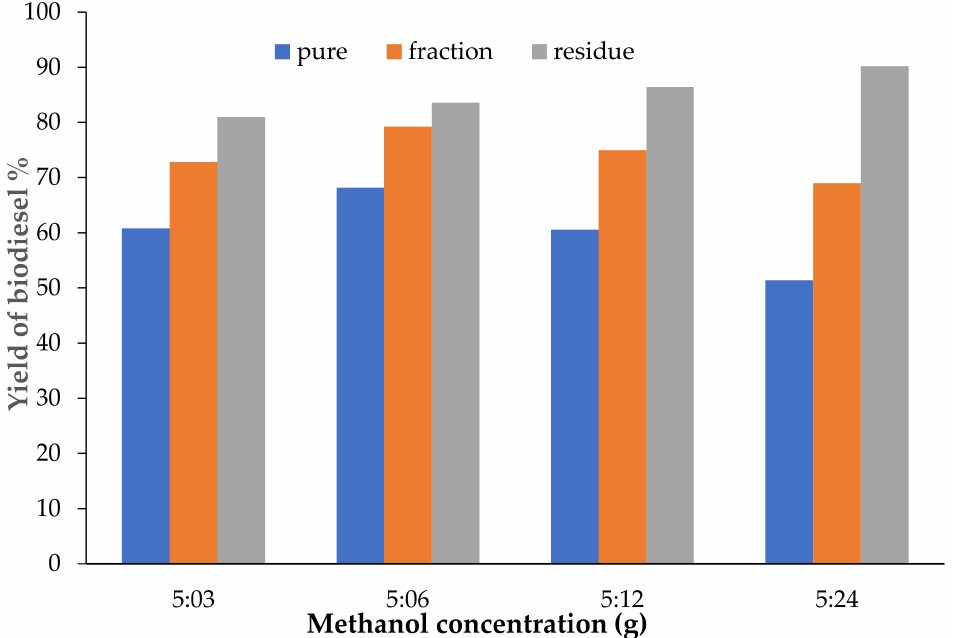
Figure 7. Effect of oil to methanol ratio on the yield of biodiesel produced from non-treated pure oil, fraction of oil, and residue.